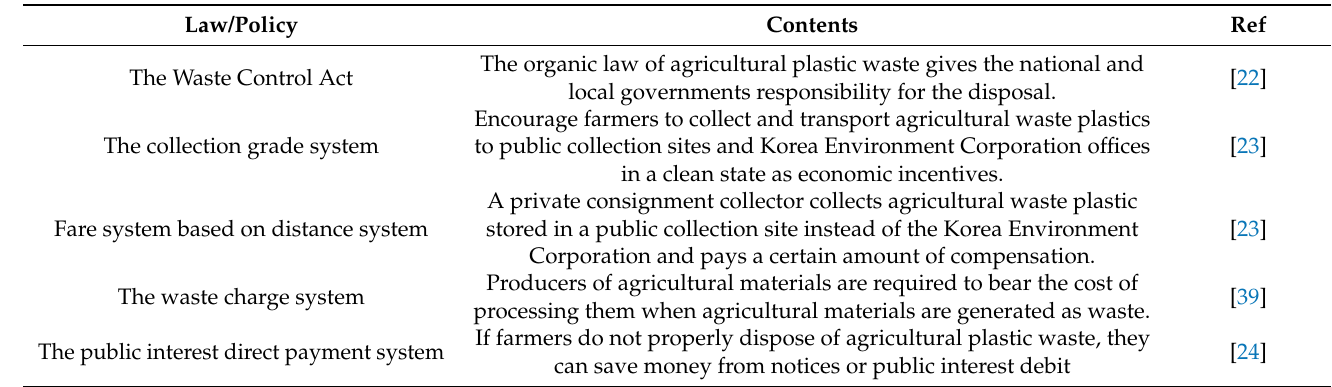
Table 4. Law and policy-related AWV management.